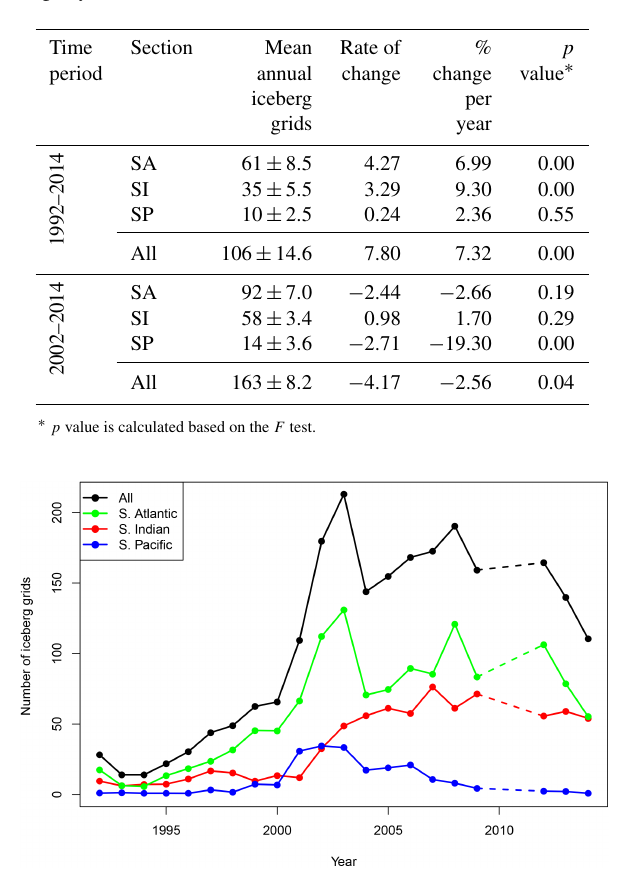
Table 8. Temporal trend of number of grids occupied by large ice- bergs by sections of the SO.